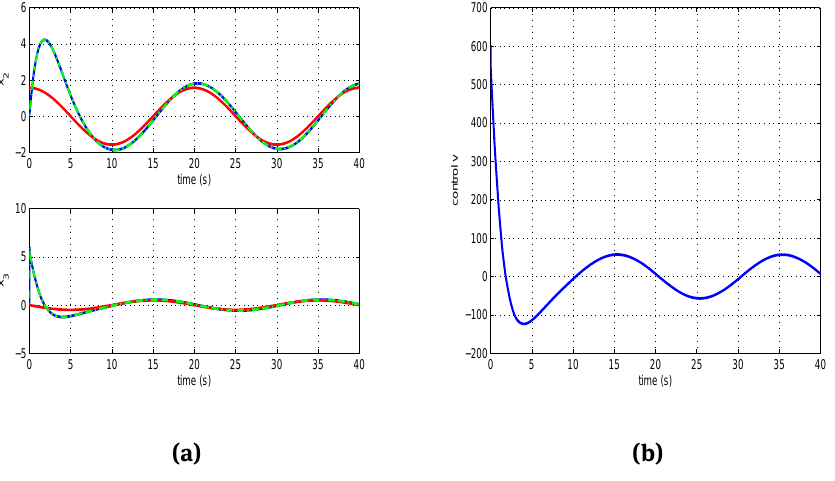
Fig. 5: Setpoint 3: (a) Convergence of the state variables of the SRM x 2 = ω , x 3 = ˙ ω (blue line: real value, green line: estimate value) by the H-infinity filter) to the associated reference values (red line). (b) Control input v applied to the control system of the SRM